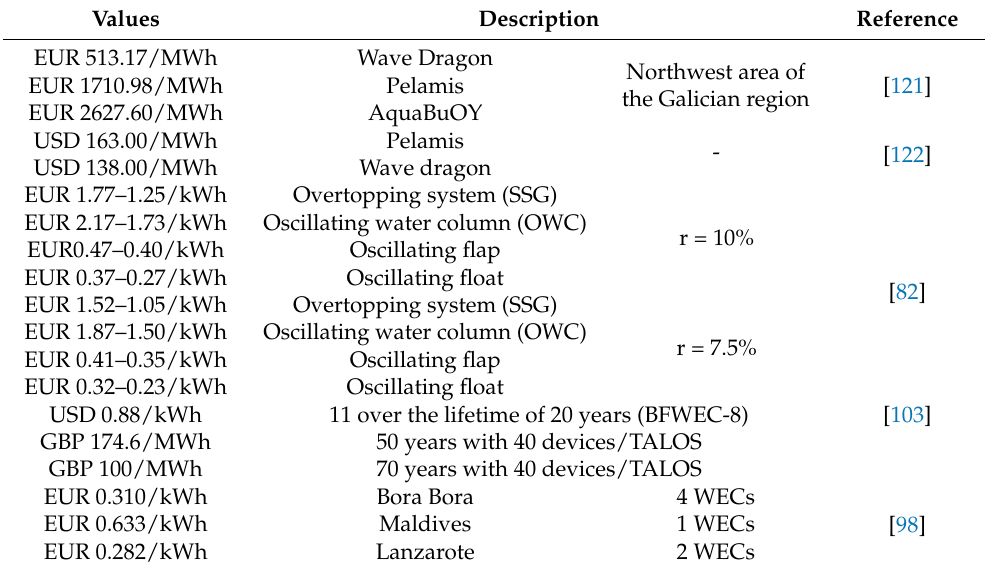
Table 6. Summary of the